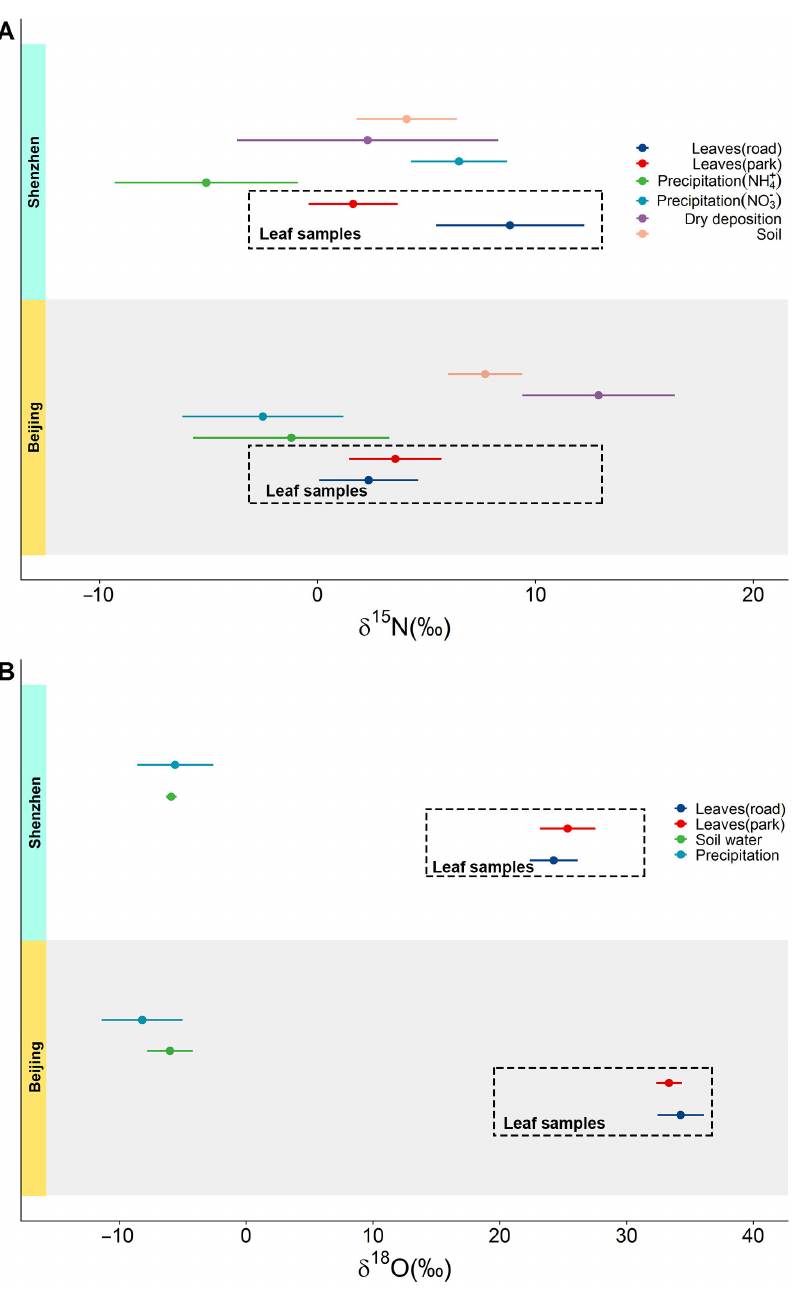
Figure 7. Comparison of the isotopic signal of leaves and potential sources: ( A ) δ 15 N in leaves and potential nitrogen sources; ( B ) δ 18 O in leaves and potential water sources. (Note: Mean values and standard deviation are shown as error bars. Data sources: precipitation [47,63–65], dry deposition [9], soil (current study), leaves (current study), and soil water [47,48]).